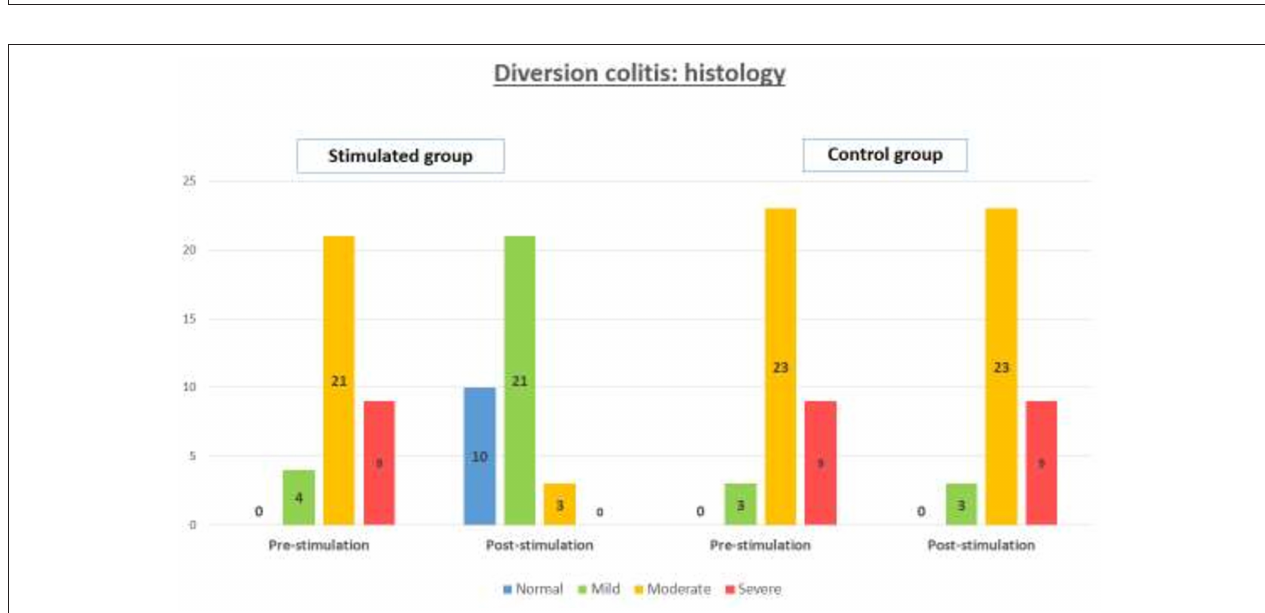
FIGURE 3 | Grade of microscopic diversion colitis, measured by histology, in the stimulated group and control group, in the pre-stimulation and post-stimulation phases.